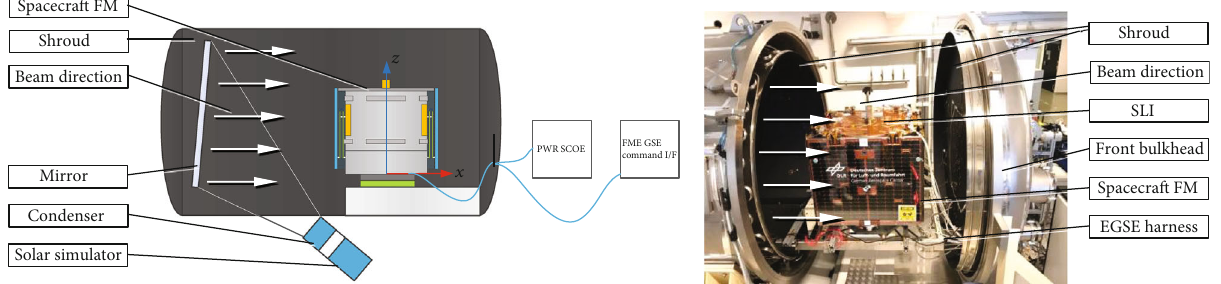
Figure 17: Spacecraft FM in space simulation facility during